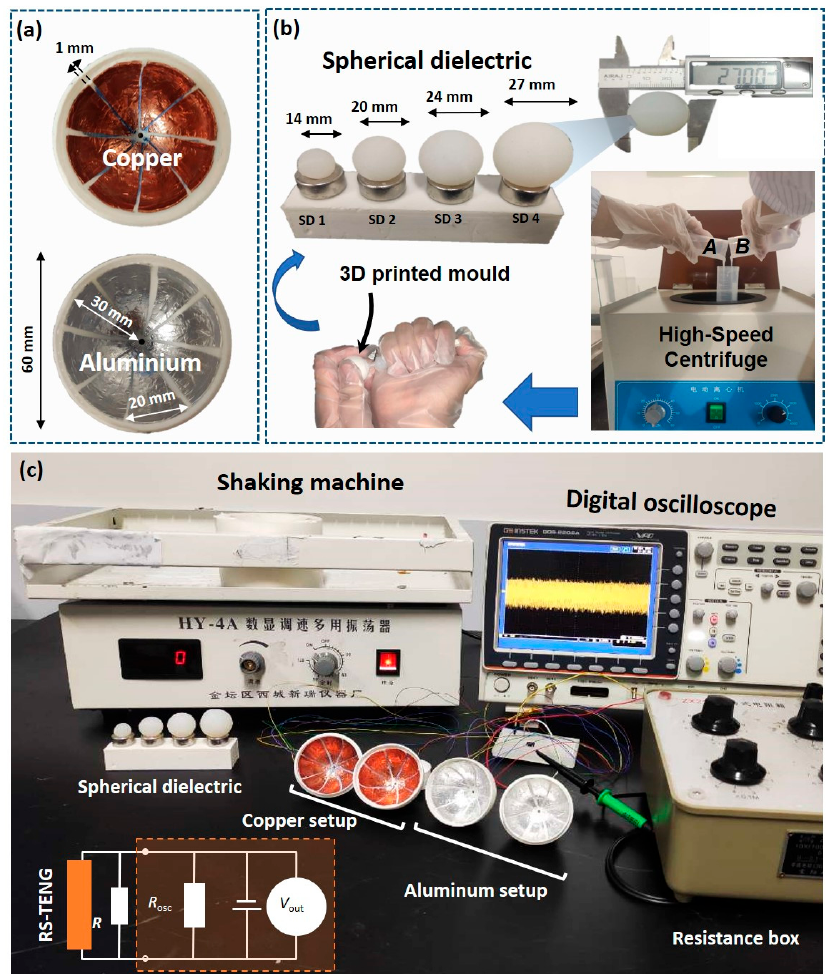
Figure 2. Fabrication and setup of the experimental RS-TENG: ( a ) design information of the copper (Cu) and aluminum (Al) frames in the RS-TENG; ( b ) fabrication of the spherical dielectric in the RS-TENG; ( c ) experimental setup and testing of the RS-TENG.